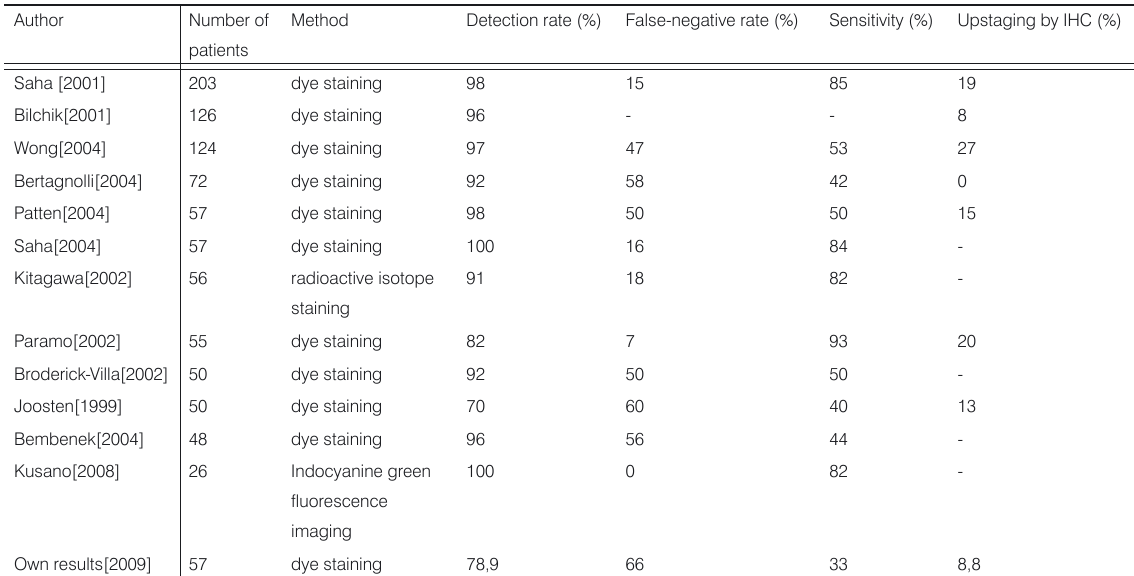
Table 4. Summary of SLNB studies in colorectal cancer